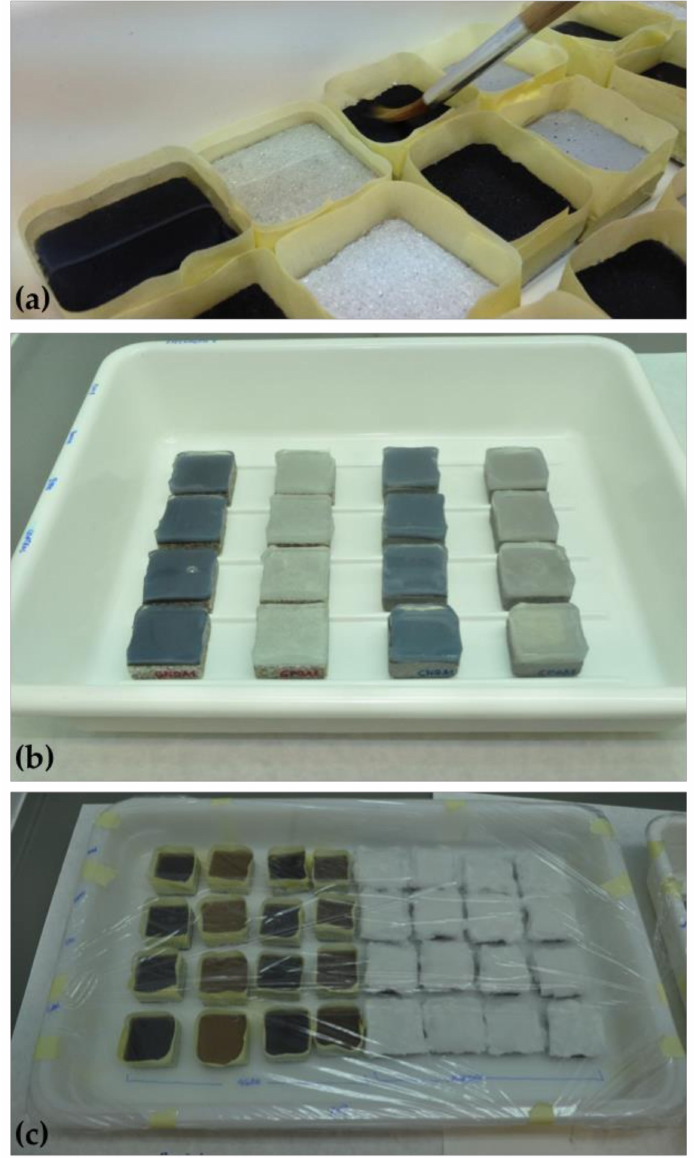
Figure 5. Biocleaning treatment with agar and cotton carriers on natural and man-made painted stone specimens. ( a ) Bacterial suspensions were brushed on to the layer of paint on the stone specimens and the warm agar was then added; ( b ) agar-treated stone specimens; ( c ) stone specimens treated